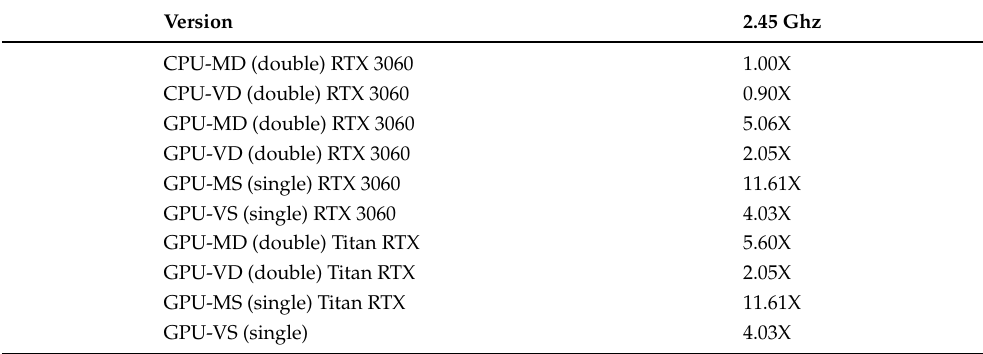
Table 19. Speed-up factors calculated using as a base the utilized execution time by CPU-MD, for the nano wave guide